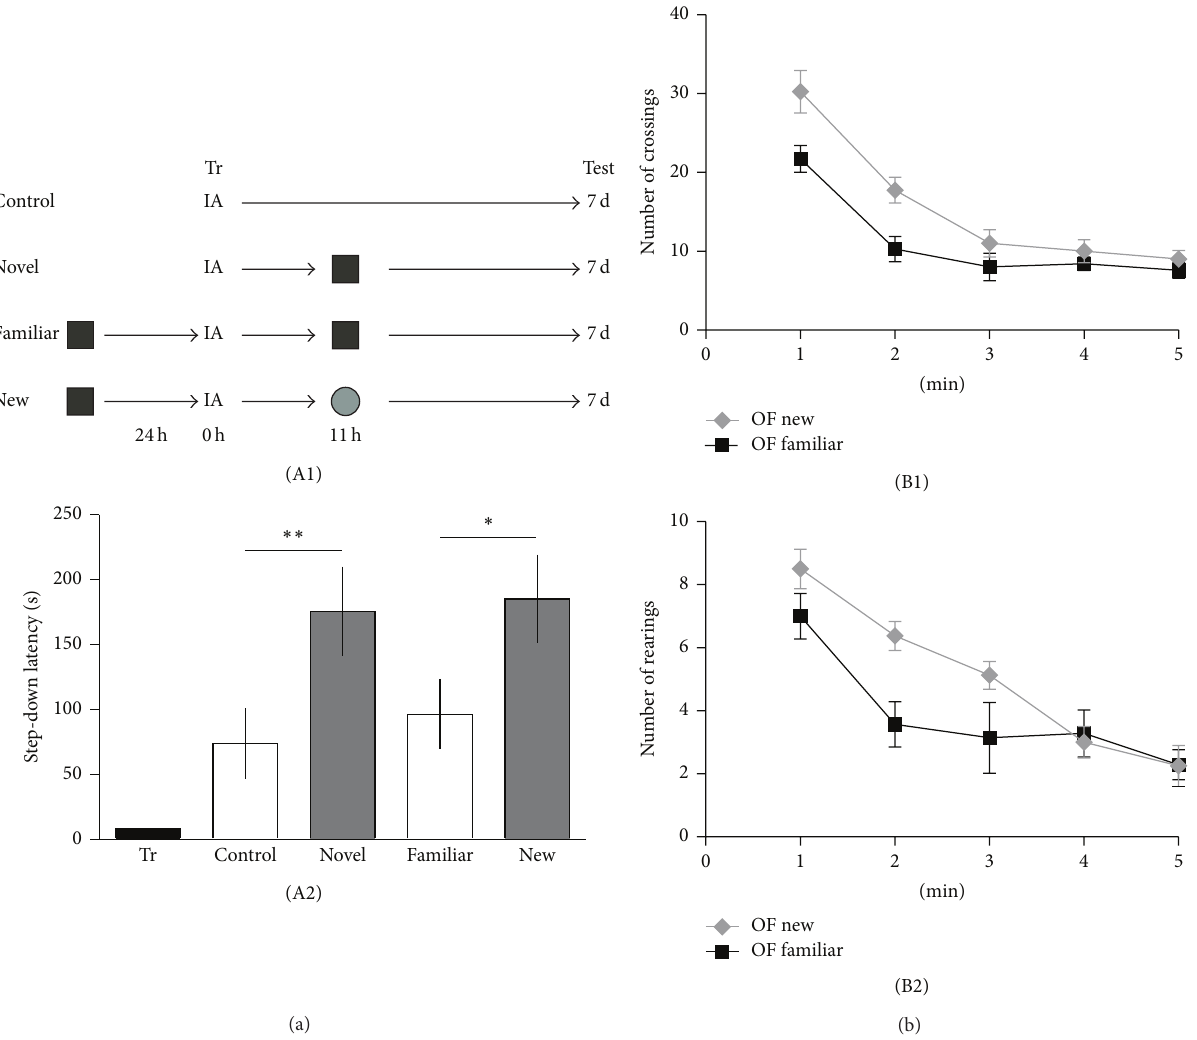
Figure 2: (a) A novel, but not a familiar, open field exposure promotes the durability of IA memory. (A1) Schematic representation of the experimental protocol is presented on the top of the panel. (A2) Animals (“Familiar” and “New” groups) were exposed for 30 min to the OF 24 h before IA training. On the day of the training, we used a different OF only for the labeled “New” group. Novel group of rats were exposed to a single OF session the day of the IA training and the control group of animals did not explore the OF. (b) Bar graph represents the number of quadrant crosses (B1) or rearings (B2) in a new or familiar OF during 5 min. Data are presented as mean ±